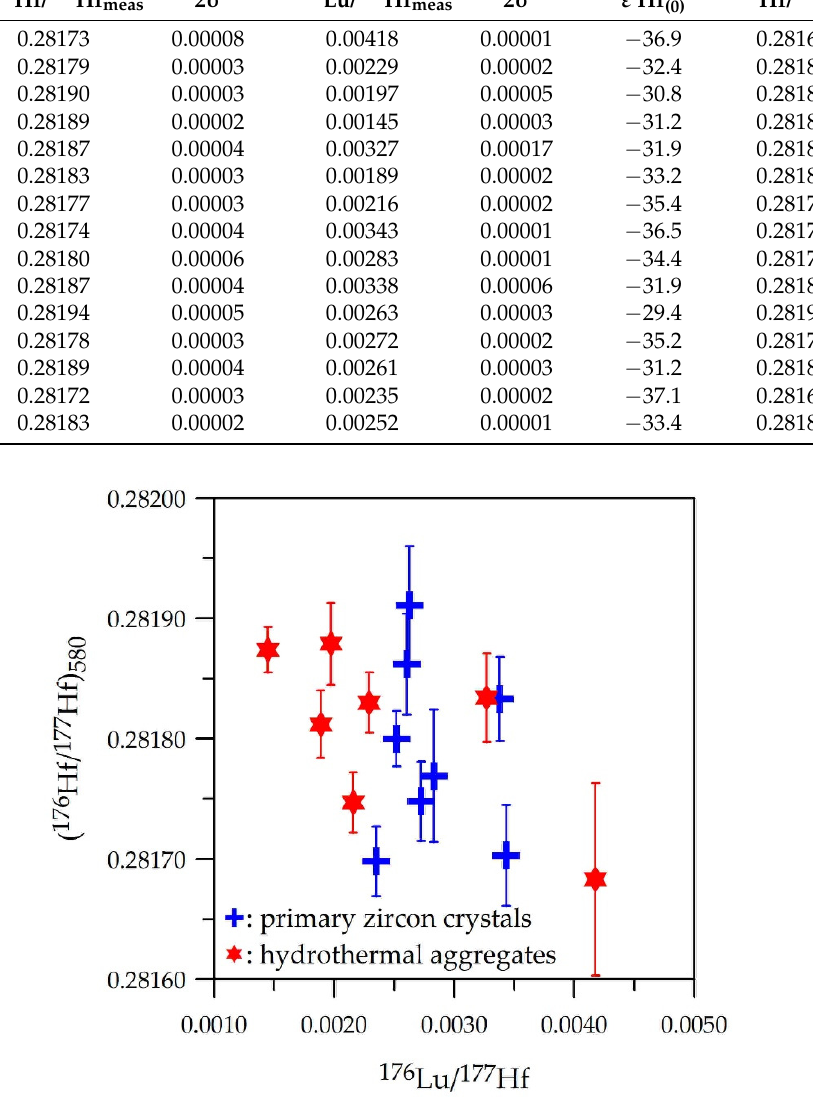
Figure 8. In-zircon initial ( 176 Hf/ 177 Hf) 580 vs. ( 176 Lu/ 177 Hf) meas diagram for primary and hydrothermal zircon crystals and aggregates, respectively. Note the similar variation range.